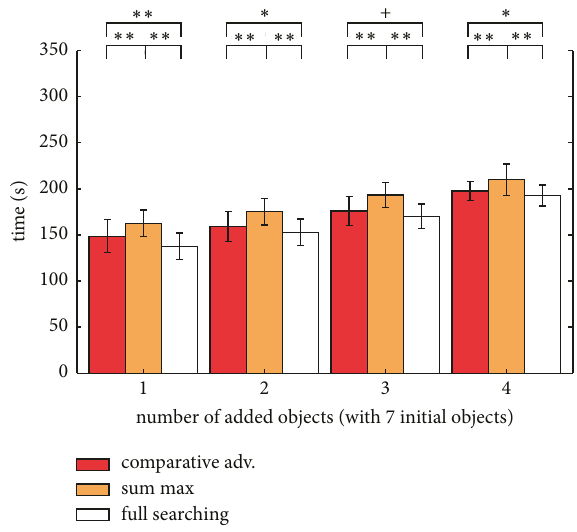
Figure 23: Makespan in situations where carrying objects can be late (four robots). ∗∗ 𝑝 < .01 , ∗ 𝑝 < .05 , and + 𝑝 < .1 . A significant 𝑝 value indicates that a significant difference in prescribing exists between the conditions. The lower 𝑝 value indicates a strong significant difference. n.s. means no significant difference between the conditions.